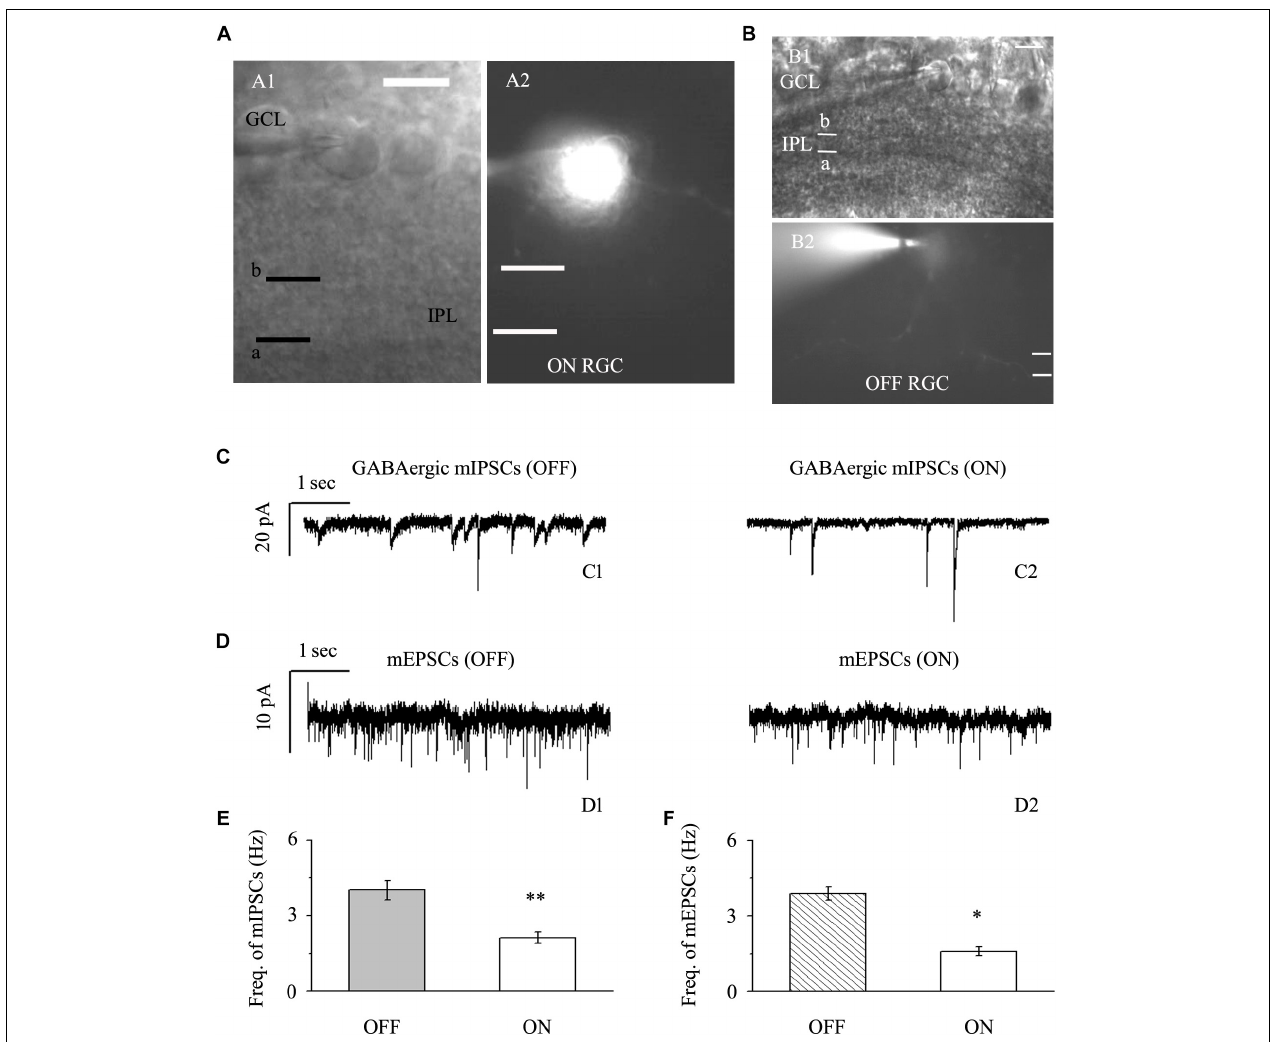
FIGURE 2 | Baseline sIPSCs and sEPSCs were more common in OFF-type RGCs than in ON-type RGCs. (A,B) The infrared interference phase microscope image in (A) shows all of the retinal layers. Representative Lucifer Yellow-filled OFF-type RGCs with dendritic arborizations in the distal (b) parts of the IPL are shown (A1, A2). Representative Lucifer Yellow-filled OFF-type RGCs with dendritic arborizations in the proximal (a) and distal (b) parts of the IPL are also shown (B1, B2). GCL, ganglion cell layer; IPL, inner plexiform layer. Scale bar, 5 µ m. (C) Representative traces showing the frequency of GABAergic mIPSCs in both OFF-type RGCs (C1) and ON-type RGCs (C2). Vertical scale bar, 20 pA; horizontal scale bar, 1 s. (D) Representative traces showing the frequency of glutamatergic sEPSCs in both OFF-type RGCs (D1) and ON-type RGCs (D2). Vertical scale bar, 10 pA; horizontal scale bar, 1 s. (E) Summarized data from 14 RGCs showing that baseline mIPSCs were more common in OFF-type RGCs than in ON-type RGCs. (F) Summarized data from 12 RGCs showing that baseline mEPSCs were more common in OFF-type RGCs than in ON-type RGCs. ∗ p < 0.05 and ∗∗ p < 0.01, unpaired Student’s t